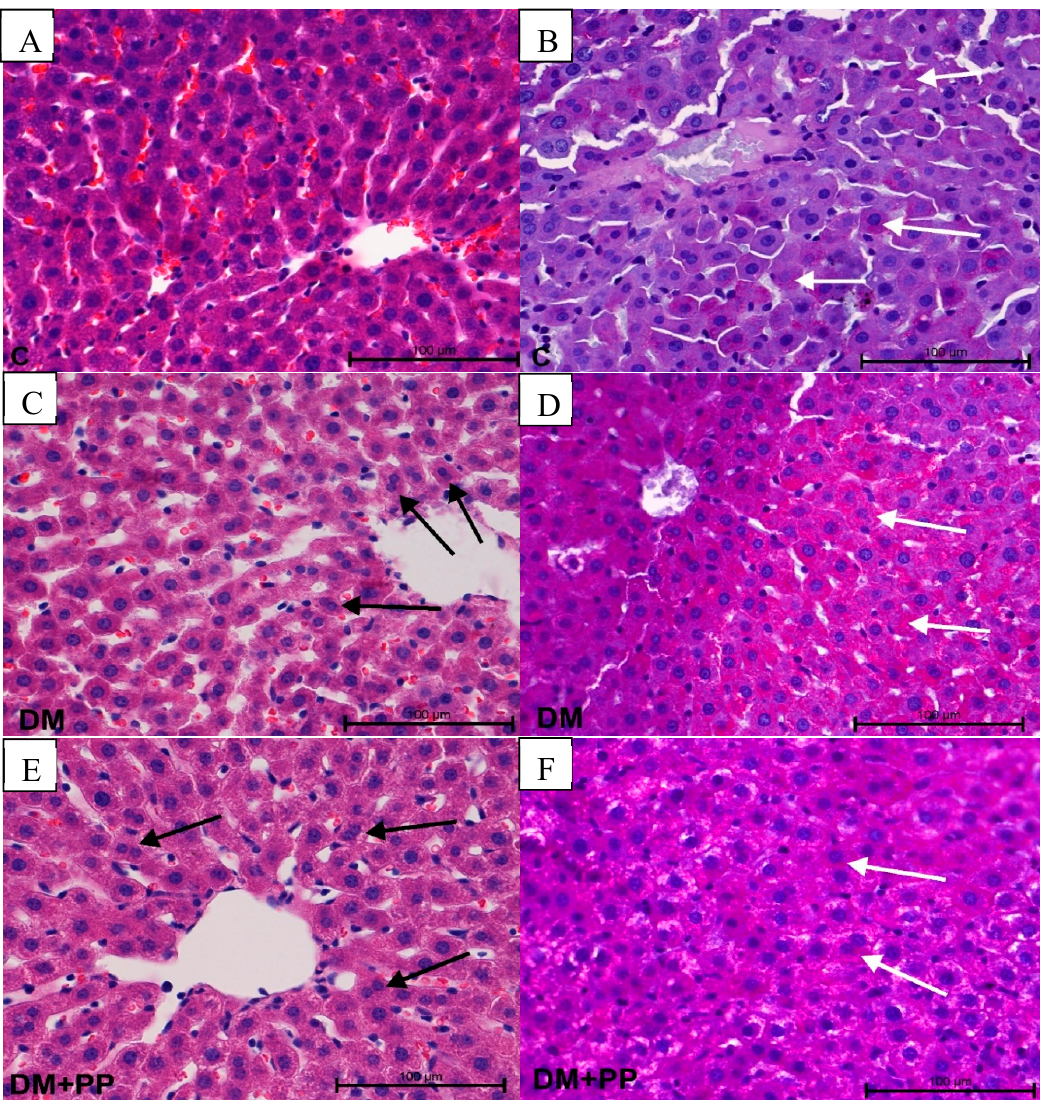
Figure 8. Histopathological studies of Blue Congo extract on the liver tissue of STZ-induced diabetic rats. Note the presence of increased number of hepatocytes with two nuclei (arrows) in the DM and DM + PP group on the left side ( C , E ). Di ff erent PAS-positive reaction (pink color) in hepatocytes (white arrows) ( D , F ). Photos on left side stained with H&E, magnification 200 × ( A , C , E ); photos on right side show PAS-positive staining, magnification 200 × ( B , D , F ). C—control rats (healthy rats), DM—diabetic rats, DM + PP—diabetic rats treated with Blue Congo extract for 14 days (at a dose of 165 mg / kg b.w. /